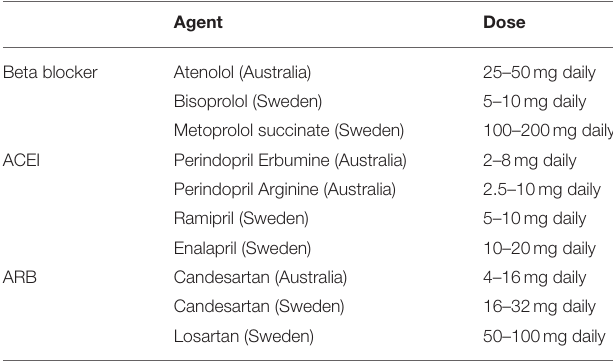
TABLE 3 | Preferred study treatments in Australia &